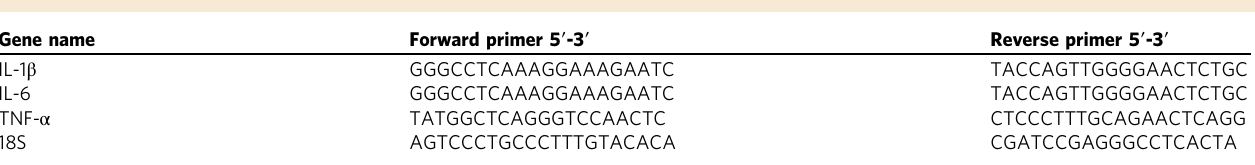
Table 1 Real-time RT-PCR primer sequences used in this